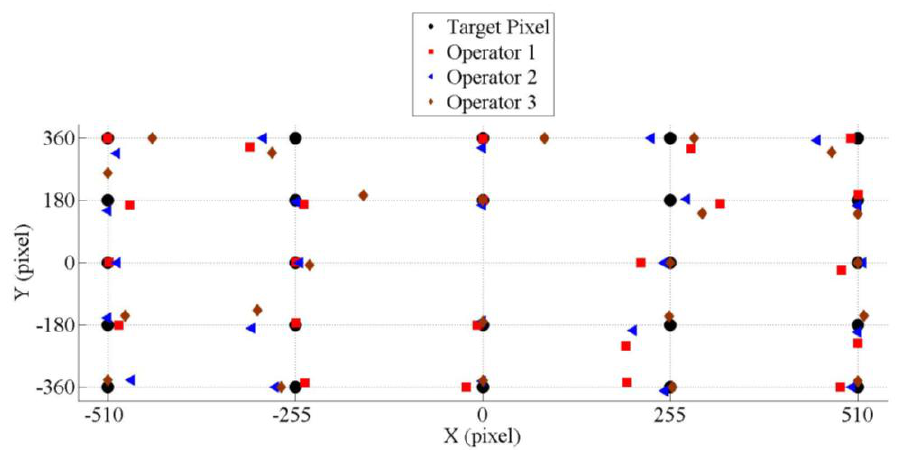
Figure 12. The average positions of actual pixels and 24 target pixels for the three operators.